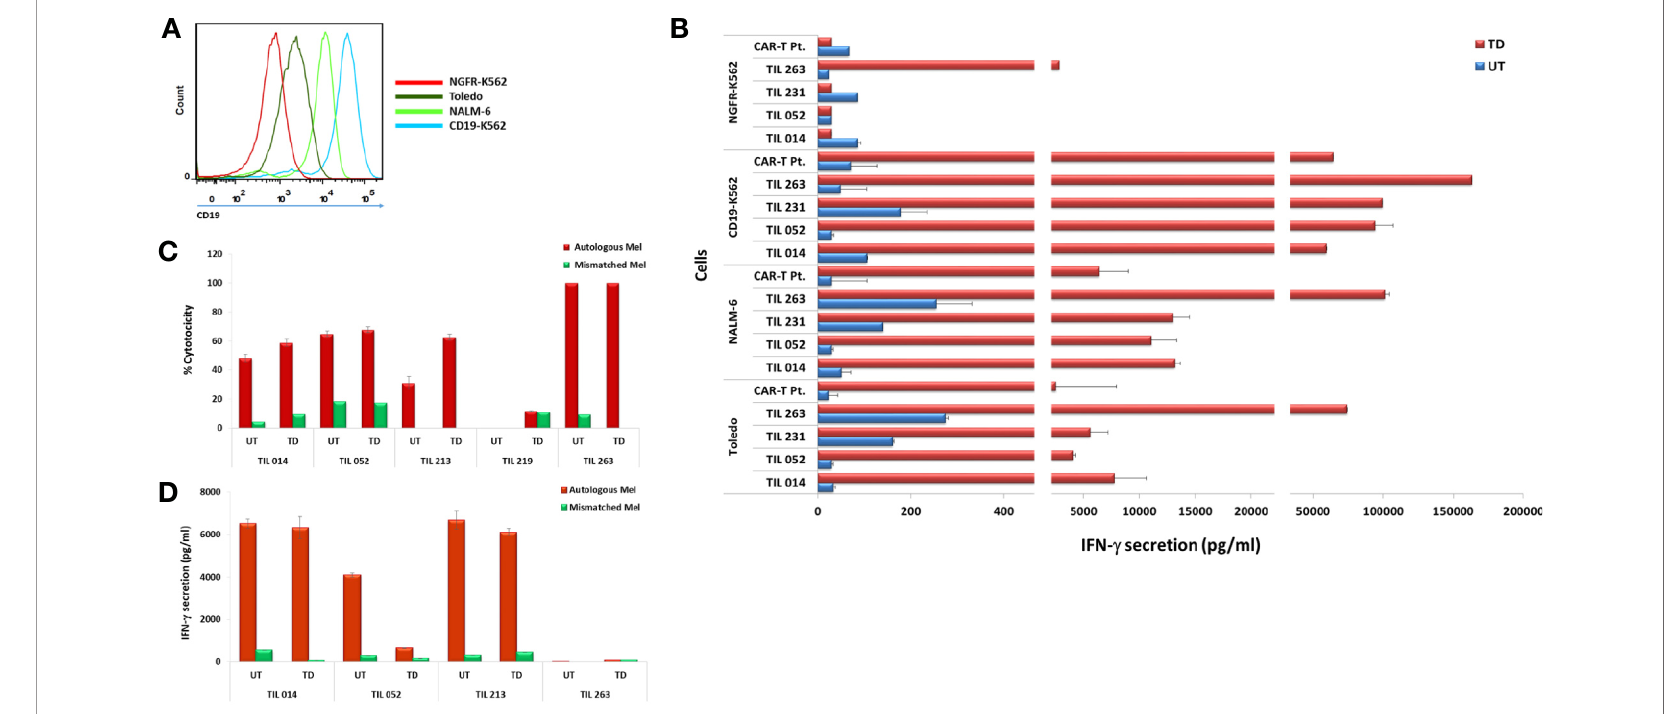
FIGURE 4 | Transduced CAR-TIL are reactive against CD19-expressing cell lines and autologous melanoma cultures. (A) Flow cytometry analysis of target cell lines for CD19 expression. (B) Transduced (TD) and untransduced (UT) TIL were co-cultured for 24 h with target cells expressing CD19 (K562-CD19, Toledo, NALM-6) or not (K562-NGFR) followed by IFN- g ELISA. CAR-T Pt. cells served as a positive control. (C) Transduced (TD) and untransduced (UT) TIL were co-cultured with autologous melanoma cells overnight at 37°C at an E/T ratio of 1:1. Growth medium was then removed and subjected to an LDH non-radioactive cytotoxicity assay. Experiments were performed in triplicates wells. (D) Transduced (TD) and untransduced (UT) TIL were co-cultured for 24 h with autologous melanoma target cells followed by IFN- g ELISA. IFN- g secretion by target cell lines alone, T cells alone, and T cells co-cultured with HLA-mismatched melanoma cell lines were below the level of detection and are not